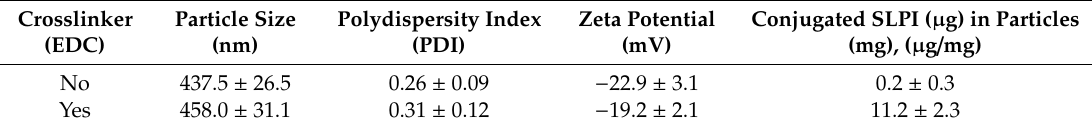
Table 3. Particle properties following preparation without / with carbodiimide. Results presented as mean ± S.D, N = 3.